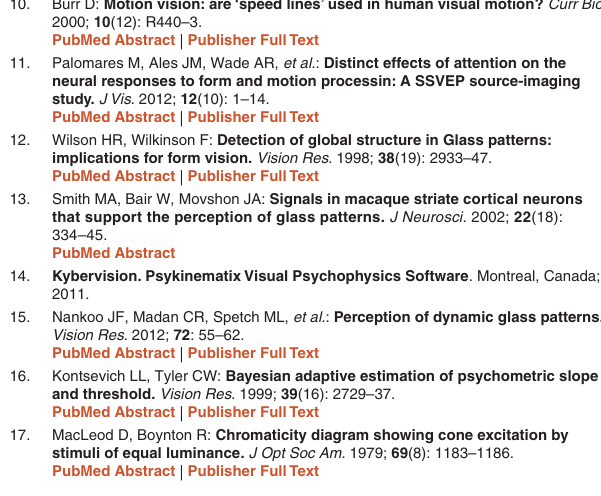
10. Burr D: Motion vision: are ‘speed lines’ used in human visual motion? Curr Biol. 2000; 10 (12):